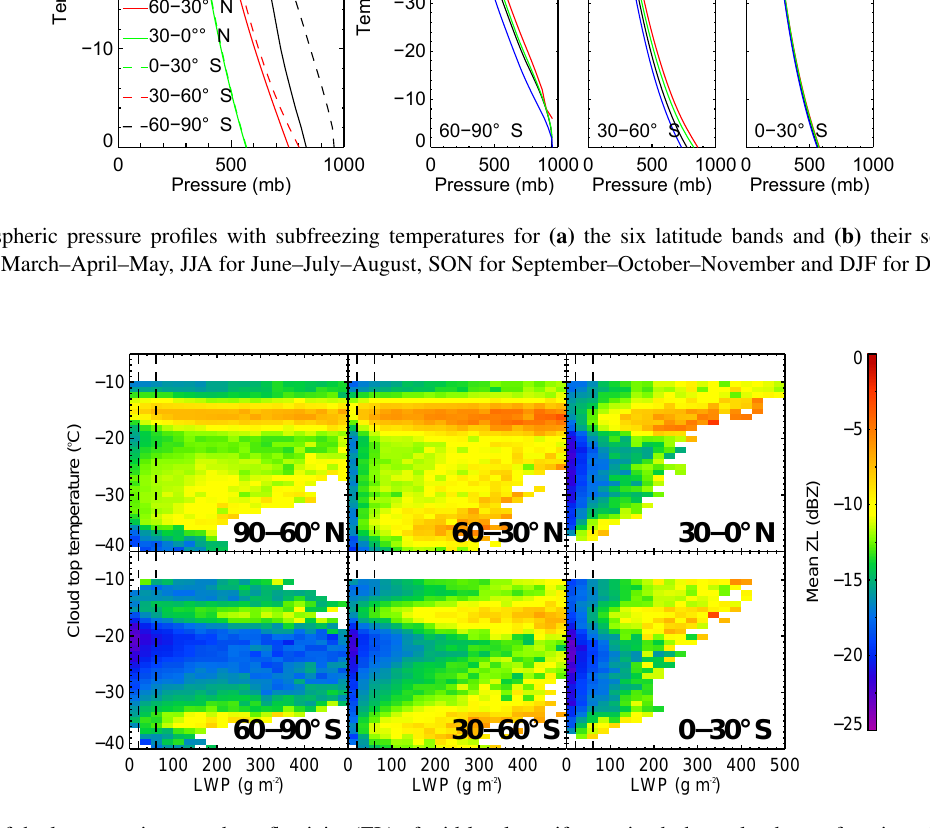
Figure 5. Mean of the layer-maximum radar reflectivity (ZL) of mid-level stratiform mixed-phase clouds as a function of cloud top temper- ature and liquid layer path (LWP). Results shown for six latitude bands as in Fig. 1. The dashed lines are the narrow range of LWP between 20 and 70gm − 2